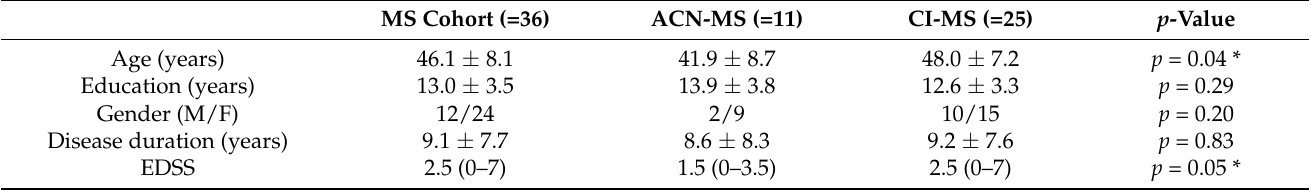
Table 1. Demographic and clinical characteristics of the whole cohort of MS patients and MS groups based on their CI